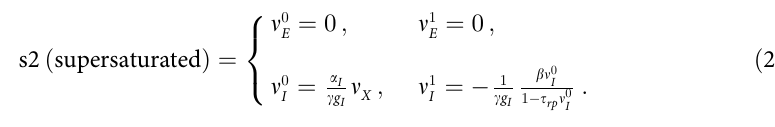
of Eqs (3)–(5) which approach s1 solutions for � = 0 transition from sublinear to supralinear as β increases (Fig 4A).